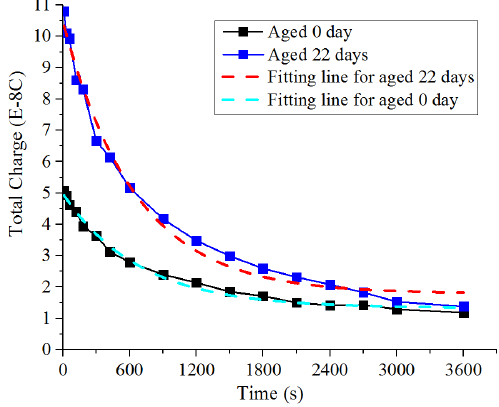
Figure 9. Charge decay in samples with new and 22 days’ aged oil under 6 kV [20].